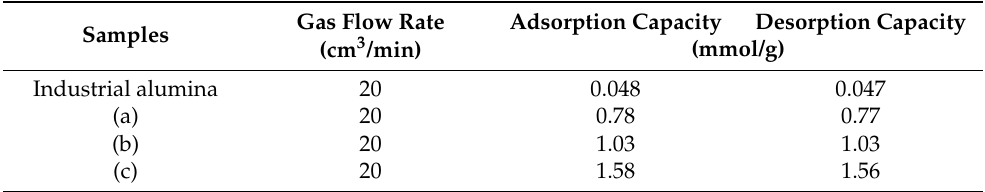
Table 7. CO 2 adsorption–desorption performance of industrial alumina and MA prepared